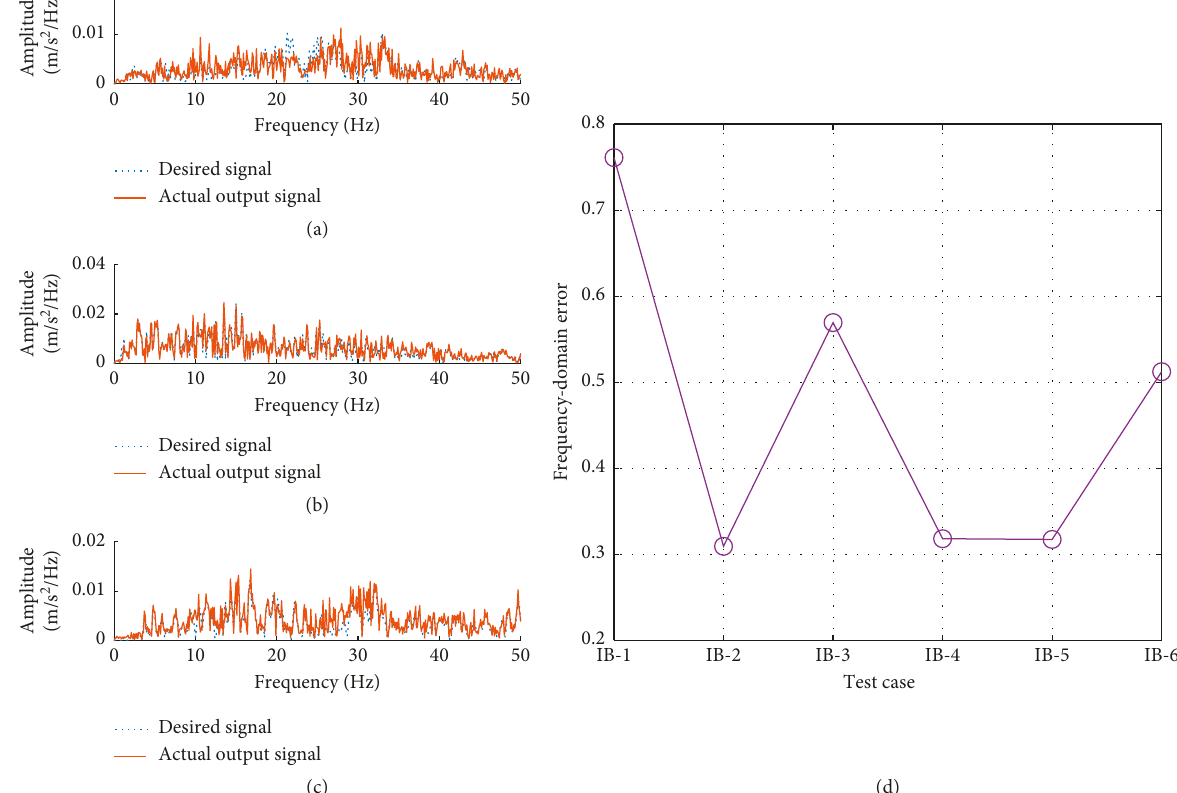
Figure 14: Desiredsignalandactualoutputsignalfrequency-domaincomparisonanderror.(a)CaseIB-1;(b)caseIB-2;(c)caseIB-3;(d)frequency- domain error of test cases.